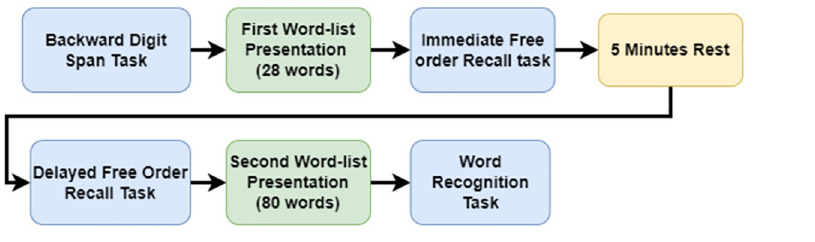
Fig 1. Flowchart of the